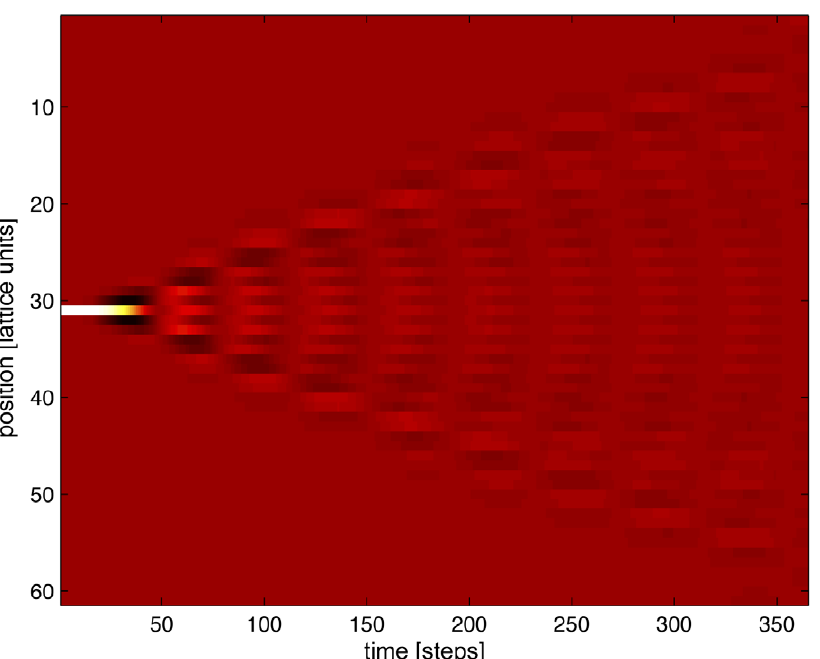
Figure 2. Numerical evolution of equation (1). The activity in a 1D slice of the 2D array (the central row) is displayed. Horizontal axis, time; vertical axis, horizontal coordinate in the array. An initial perturbation at time 0 expands outwards at asymptotically constant speed, with characteristic ripples looking like a ‘‘wave’’ which attenuates algebraically as it goes out.